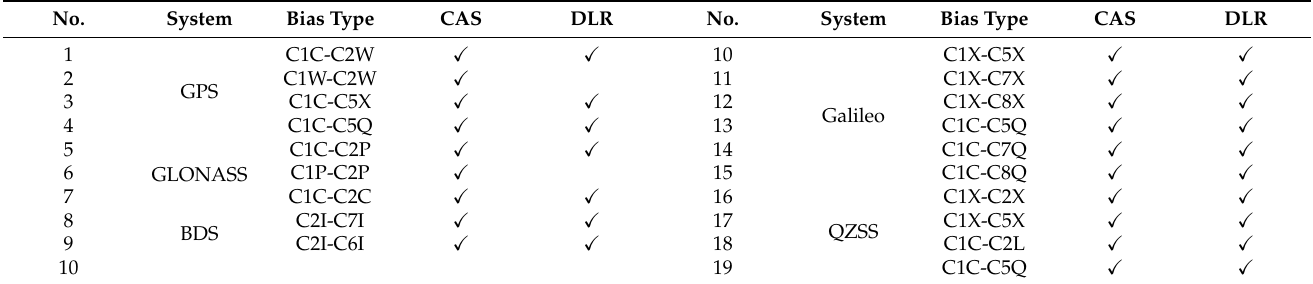
Table 1. Information on the MGEX DCB products provided by CAS and